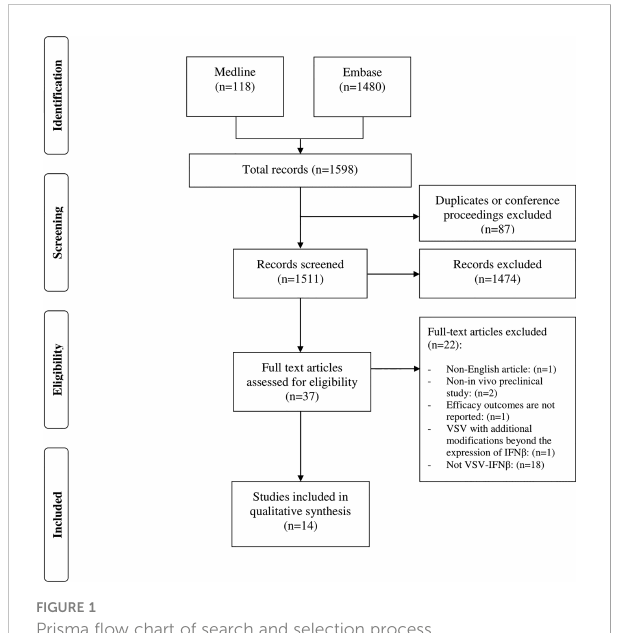
FIGURE 1 Prisma fl ow chart of search and selection